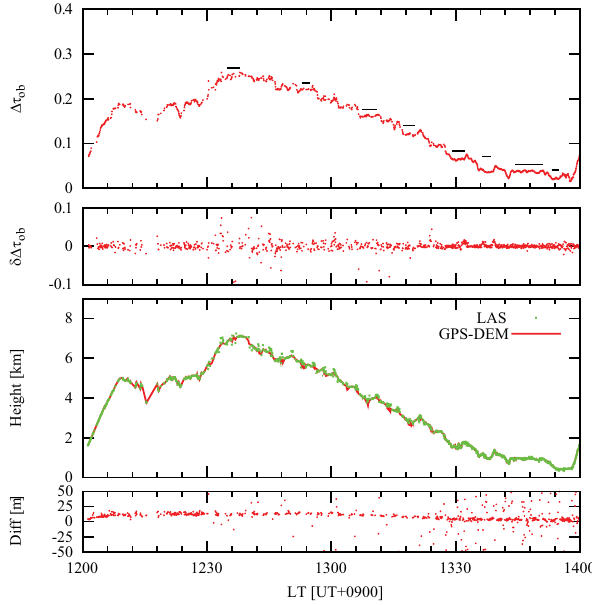
Fig. 5. Results of airborne flight measurements taken on 26 Au- gust 2009. The upper two panels show the differential absorption optical depth ( 1τ ) and its fluctuations versus time, and the lower two panels represent the heights and their differences obtained from LAS and airborne GPS and DEM. The LAS measurement was car- ried out with cloud screening. XCO 2 is calculated from averaged 1τ indicated by solid line in the top panel. The measured data from the LAS were corrected according to the information flight attitude. However, some peaks at 1τ and aircraft height resulted from im- perfect correction of the viewing